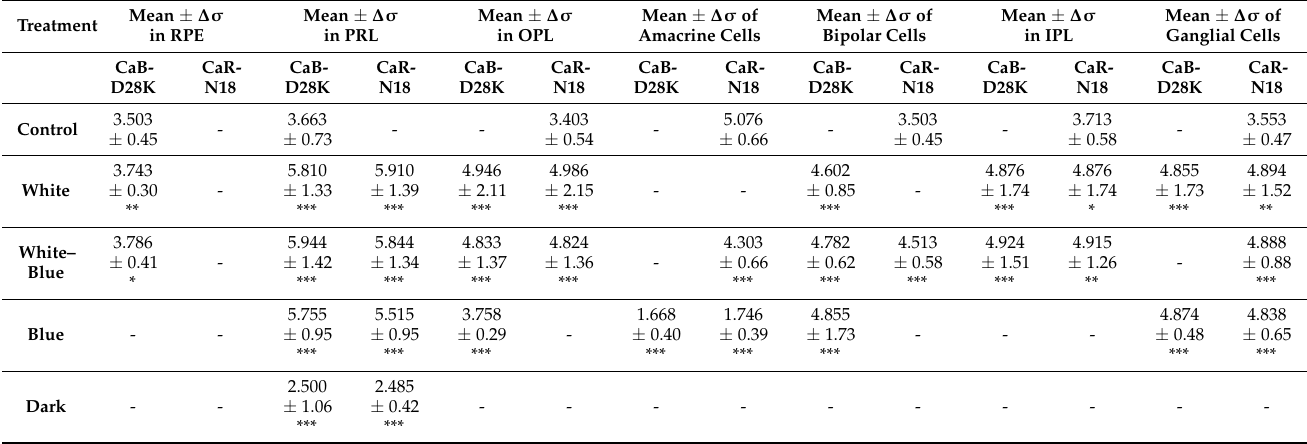
Table 2. Mean data ± standard deviation ( ∆ σ ) of immunopositivity of: GC (ganglion cell); IPL (inner plexiform layer); INL (inner nuclear layer); OPL (outer plexiform layer); ONL (outer nuclear layer); RPE (retinal pigment epithelium) detected by Calbindin (CaB-D28K) and Calretinin (CaR-18N). Experimental conditions: control (natural photoperiod), white light with a 34.8% of blue light emission (W), white–blue light with a 54.6% of blue light emission (WB), blue light with an 84.3% of blue light emission (B), and darkness (D). The statistical analysis shows a different distribution pattern of the two proteins between the experimental groups compared to the control. All features were evaluated per 174.286 ± 3.082 µ m (mean). Statistical significance: *** p < 0.001, ** p < 0.01, * p <